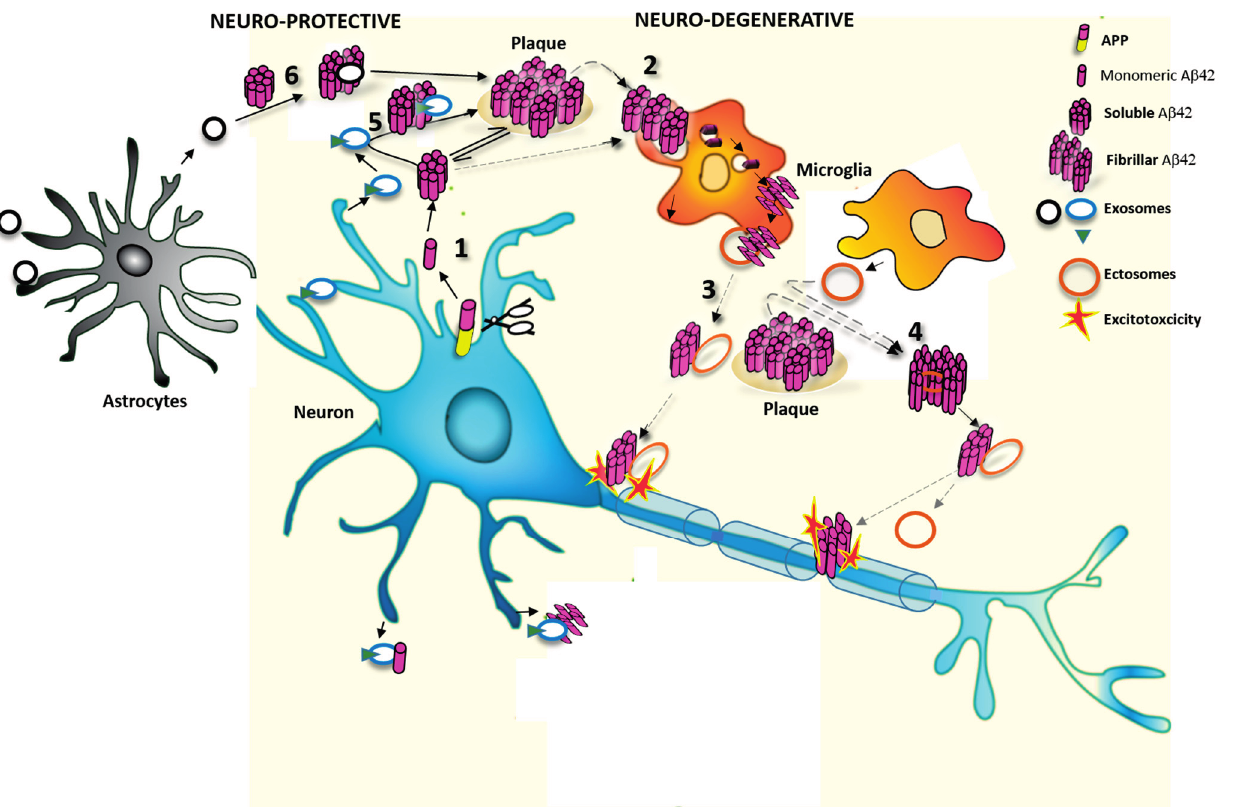
Figure 1. ( 1 ) Cleavage of APP leads to formation of monomeric A β 42 forms, which aggregate to form soluble A β 42 oligomers. Oligomers are then converted to insoluble fibrils, the main components of amyloid plaques; ( 2 ) Fibrillar and soluble A β 42 species are internalized and degraded by microglia; ( 3 ) A fraction of internalized A β 42 can be re-secreted as neurotoxic form, in association with microglial ectosomes [60]; ( 4 ) Microglia-derived ecotosomes also promote formation of soluble A β 42 species from extracellular insoluble aggregates [60]; ( 5 , 6 ) In contrast to ectosomes, exosomes released by neurons or astrocytes promote aggregation of seed free soluble A β 42 [51,56]. Neuronal exosomes may promote A β 42 clearance by microglial cells